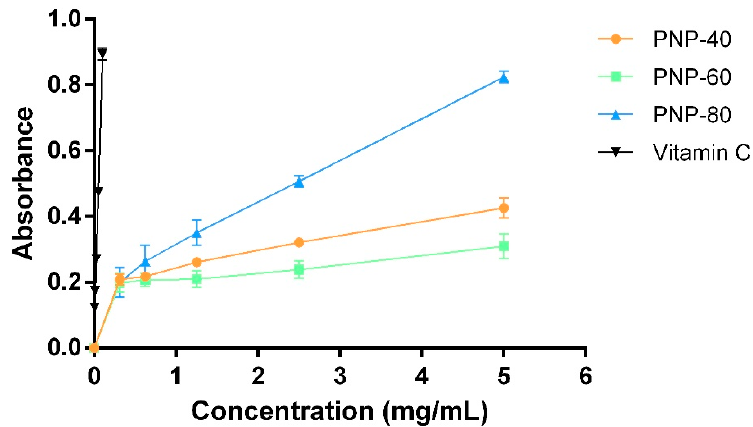
Figure 1. Reducing power of PNPs and vitamin C at different concentrations. The experiments were conducted in triplicate independently ( n = 3), and the data are expressed as the means ± standard error (SE).